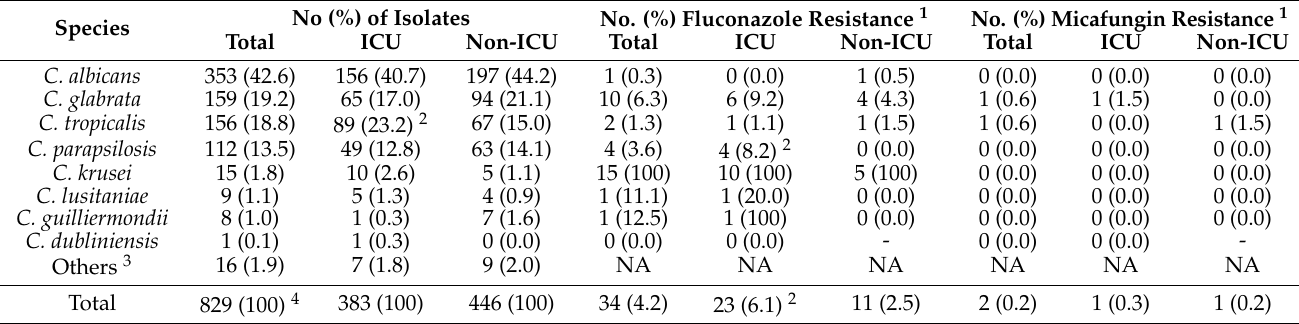
Table 1. Species distribution and antifungal susceptibilities of 829 Candida bloodstream isolates from 370 ICU and 437 non-ICU patients in 11 hospitals over a two-year